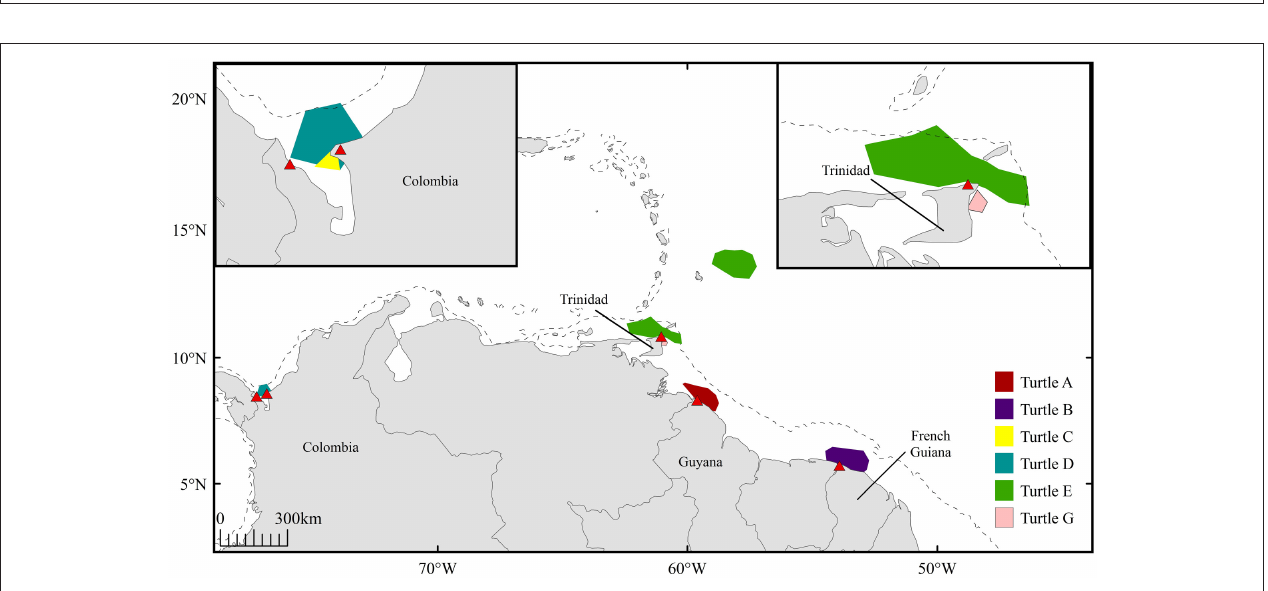
FIGURE 3 | High-use areas defined by 50% volume contours for mature male ( n = 12, blue) and female ( n = 7, red hatched) leatherbacks throughout the 120-day pre-nesting interval. Dashed line represents 200m isobath.